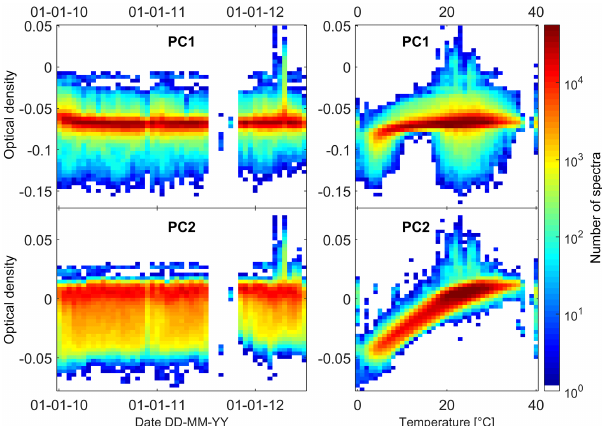
Figure 3. Peak-to-peak apparent optical density (e.g. peak-to-peak optical depth of the principal component times the fit coefficient) of the first and second principal components for instrument D2J2201 at Nevado del Ruiz. In the left column the principal components are shown as a function of time and in the right column as a function of instrument temperature. It appears that PC1 describes a constant apparent spectral feature of the instrument while PC2 describes a temperature-dependent